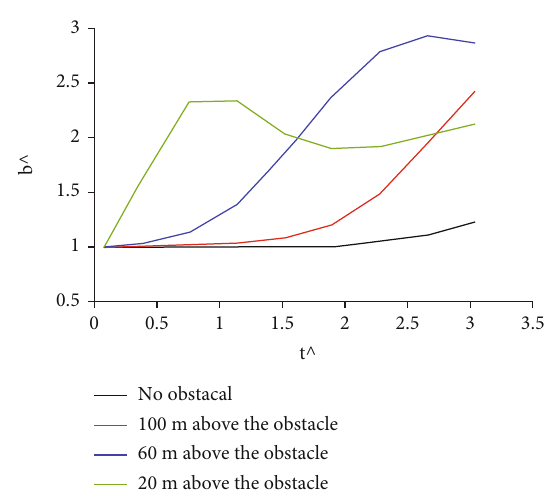
Figure 21: Variation of wake vortex core